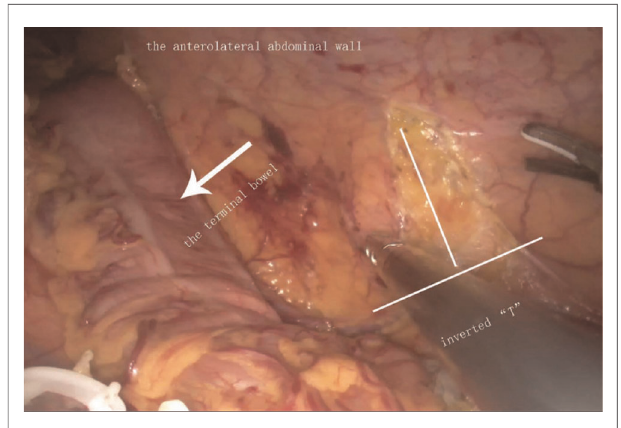
FIGURE 1 | Tunnel